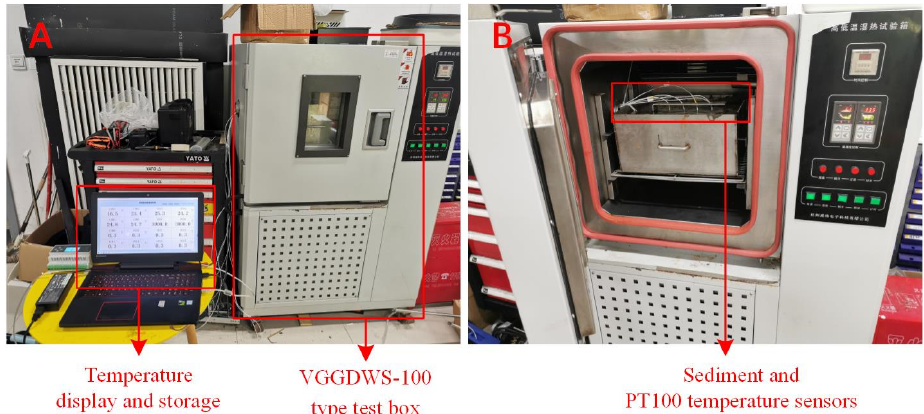
Figure 10. Heating experiment in the laboratory incubator. ( A ) overview photo of experiment in the laboratory incubator; ( B ) photo of sensor arrangement in incubator.